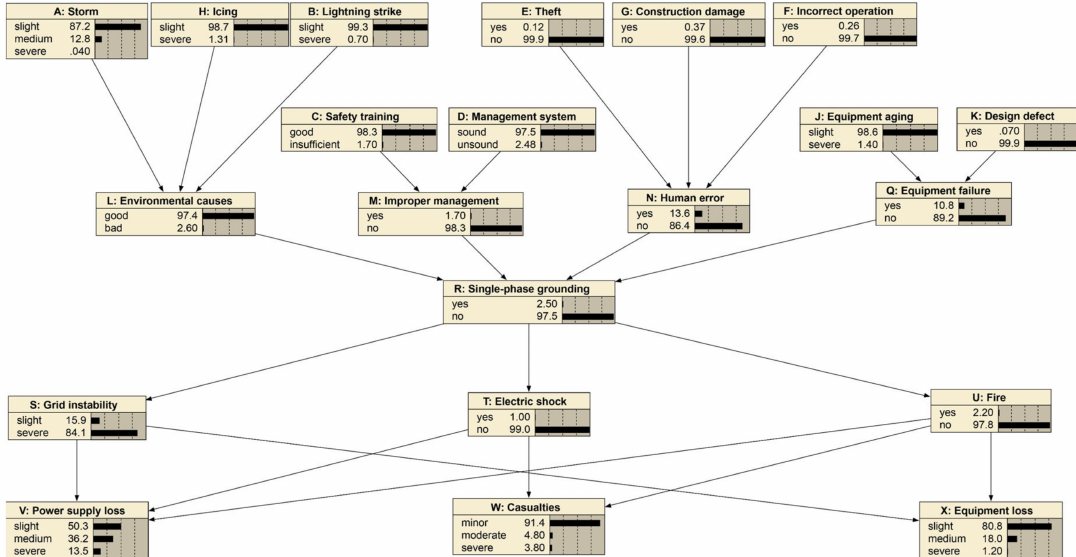
Figure 5. Initial Bayesian network for representing single-phase grounding